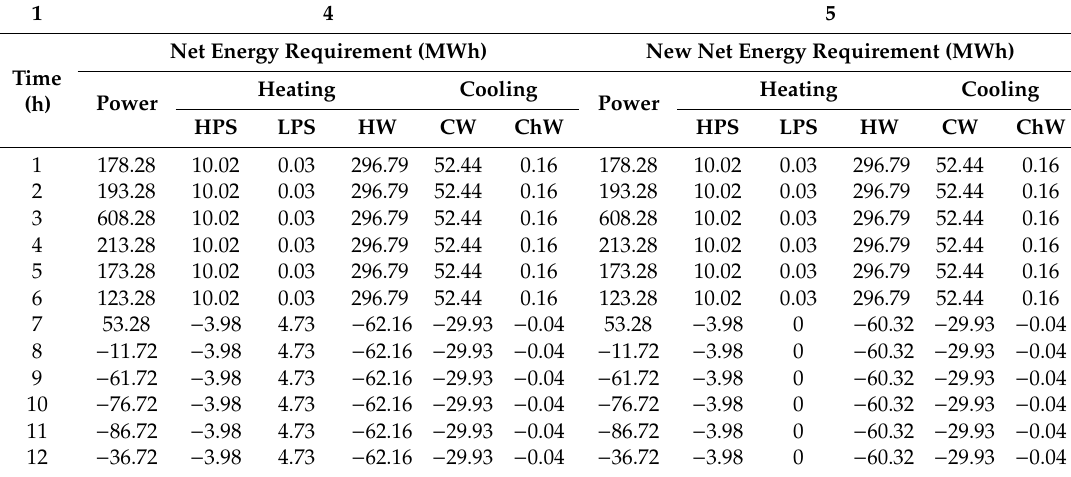
Table A11. TriGenSCA after iteration from time 1 to 12 h.